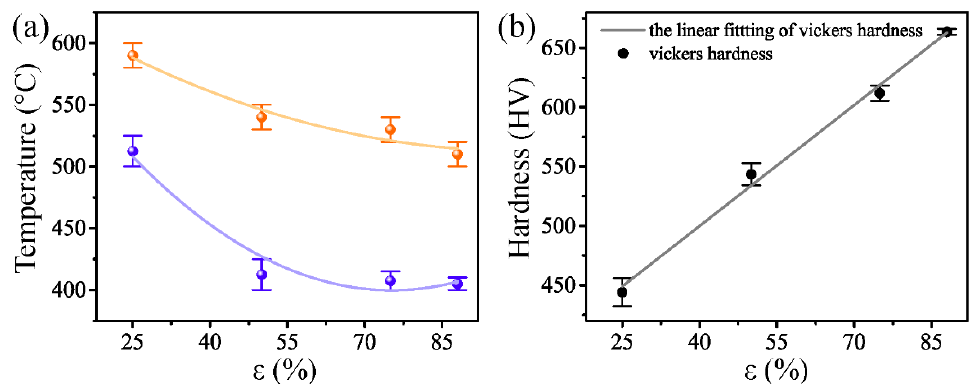
Figure 8. ( a ) The correlation between recrystallization temperatures and CR deformation. ( b ) The interrelation between hardness and CR deformation of Fe – 19Mn – 0.6C TWIP